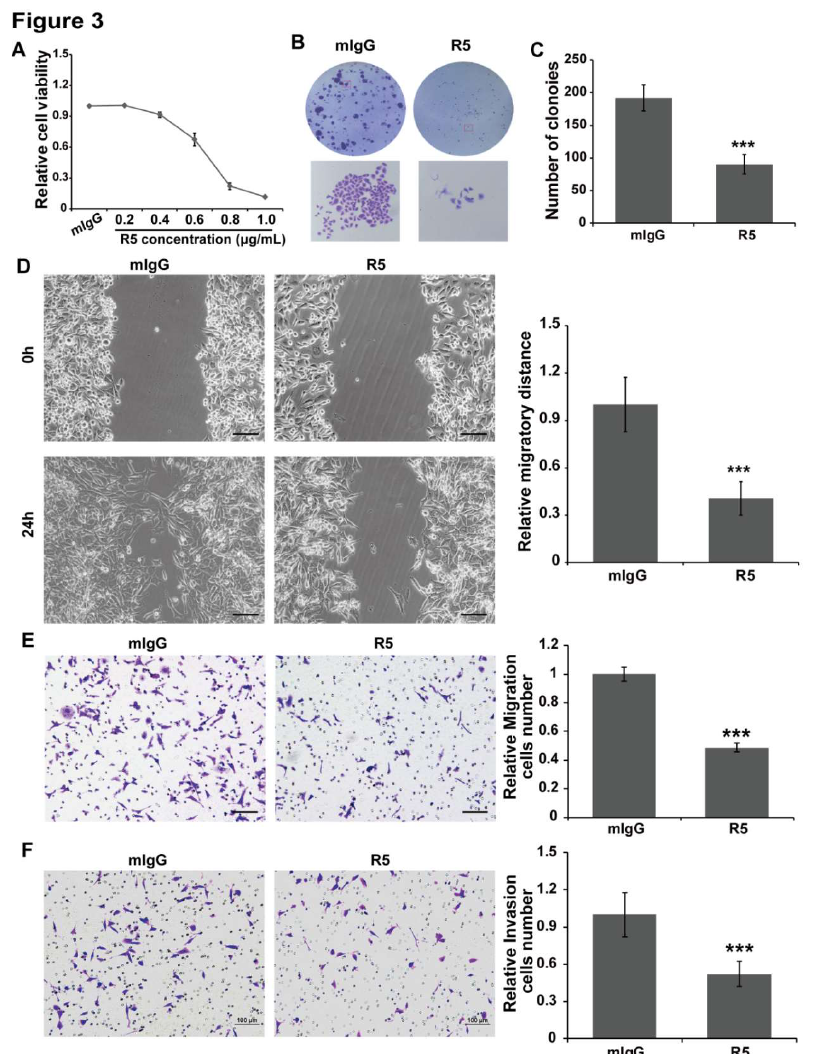
Figure 3. Blocking of Slit2 / Robo1 signaling inhibits the growth, migration, chemotactic, and invasion ability of Lovo cells. ( A ) The indicated concentration of R5 was added to Lovo cells and the cell viability was measured using the CCK8 (Cell Counting Kit-8) assay 48 h later. R5 inhibited cell viability in a dose-dependent manner, and the IC 50 (half maximal inhibitory concentration) is ~0.7 µ g / mL in Lovo cells. Lovo cells were seeded at the density of 1000 cells and treated with 0.7 µ g / mL of mIgG or R5. ( B ) The size of a single colony was smaller in R5-treated wells compared with mIgG-treated wells. ( C ) The total number of colonies in R5-treated and mIgG-treated wells of Lovo and SW480 cells were counted, and fewer colonies can be seen in R5-treated wells compared with mIgG-treated wells. ( D ) A wound healing assay was used to detect the inhibition e ff ect of the blocking of Slit2 / Robo1 signaling on cell migration. Lovo cells were treated with mIgG or R5, and the cell migration distance was detected 24 h later. R5 significantly inhibited cell migration compared with mIgG in Lovo cells. ( E ) The Transwell migration assay was used to detect the chemotactic ability of Lovo cells. The number of cells that migrated to the lower membrane was decreased in the R5 treatment group compared with that of the mIgG treatment group. ( F ) The inhibition e ff ect on cell invasion was detected using the Matrigel invasion assay. Lovo cells were added into the upper chambers and treated with mIgG or R5 at the same time, and the invasion of the cells to the bottom of the chambers was measured 20 h later. Specific blocking of Slit2 / Robo1 signaling using R5 significantly suppressed cell invasion in Lovo cells compared with mIgG. *** p < 0.001. Scale Bars: 100 µ m. The results are representative of three independent